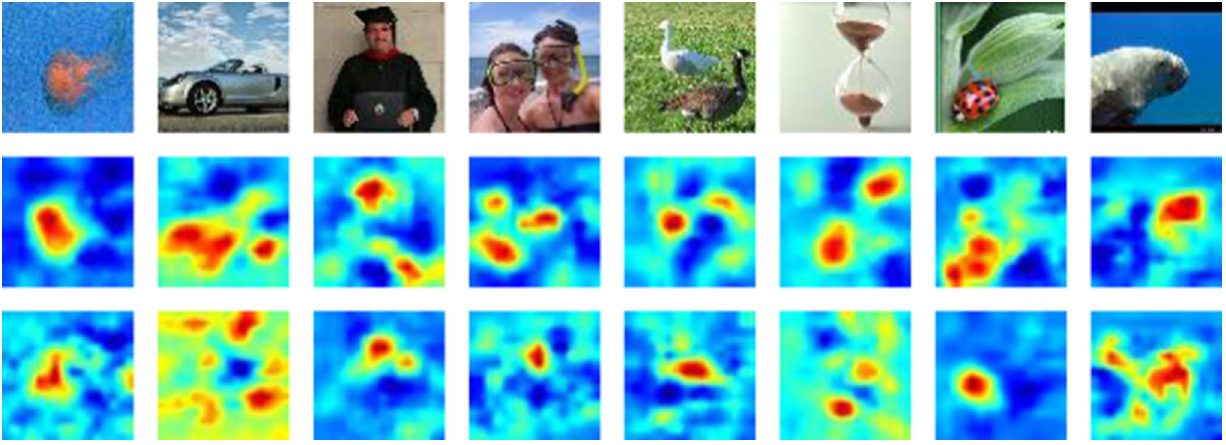
Fig. 6 The class activation mapping of the proposed method and the original networks over the Tiny ImageNet dataset. Our visualizations are more accurate in representing the objects. Images of the first row